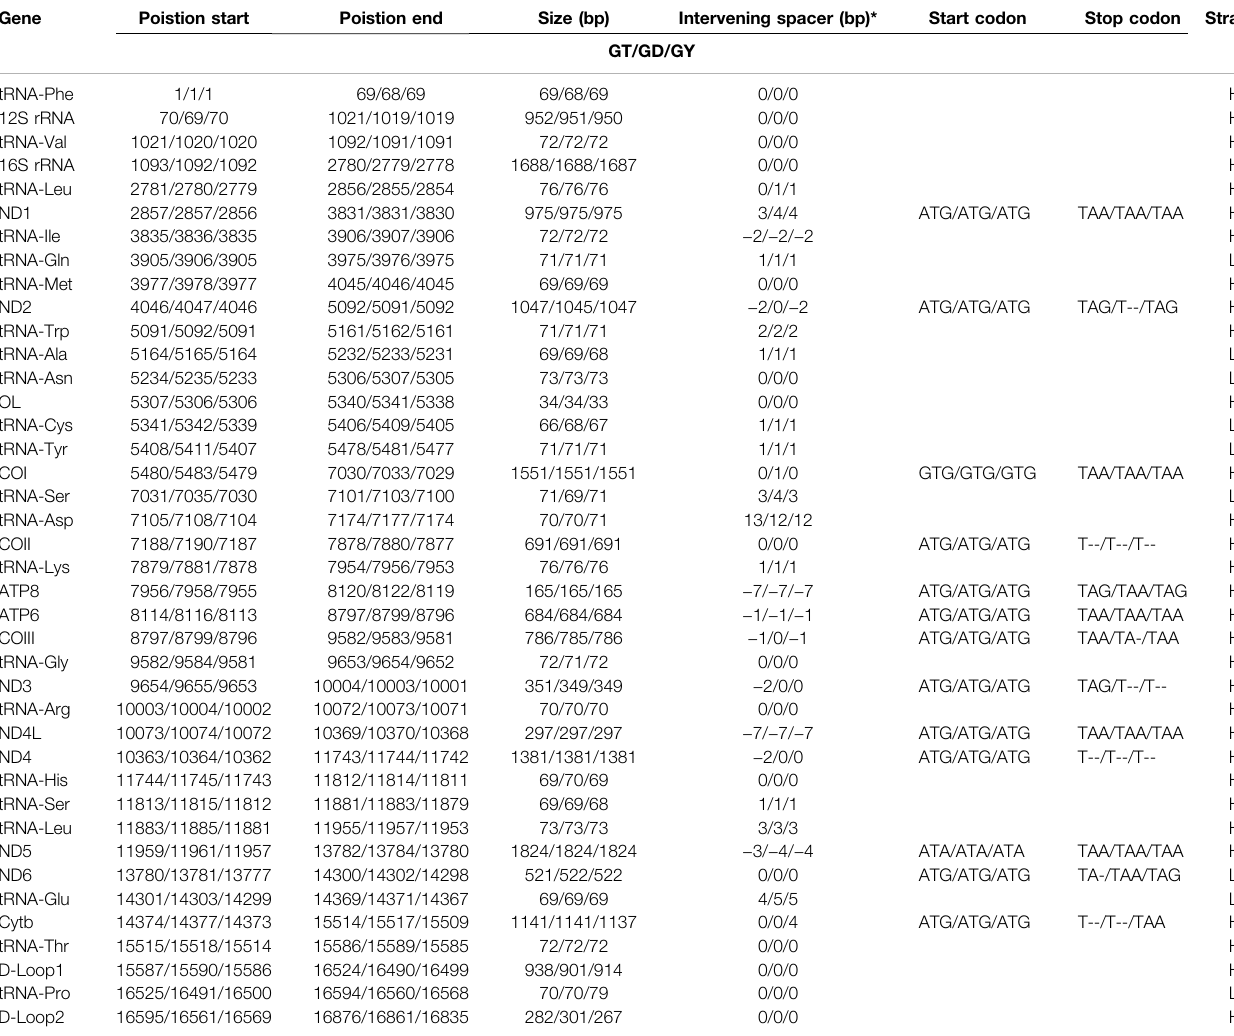
TABLE 1 | Summary of gene/element feature of Garra dengba (GD), Garra tibetana (GT) and Garra yajiangensis (GY). Gene Poistion